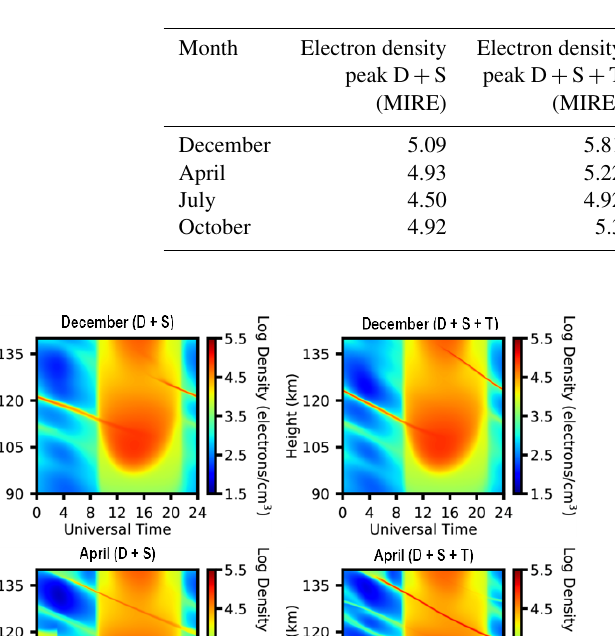
Table 2. Comparison of the simulated E s layer densities in MIRE with the D + S, D + S + T component and the maximum average daily density from the observed ionosonde data.